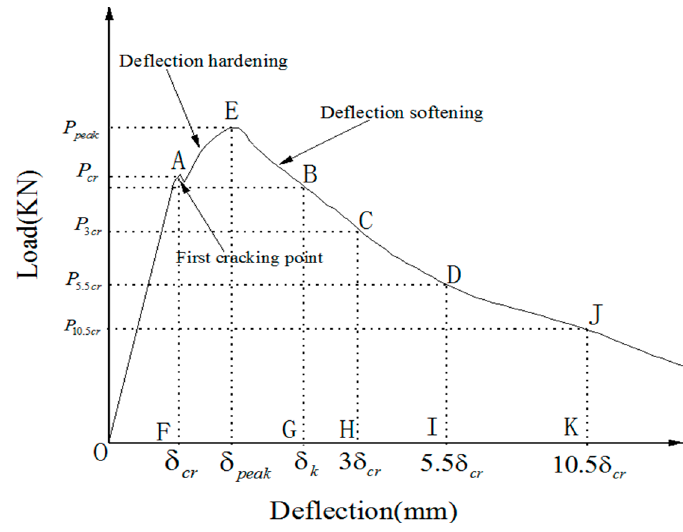
Figure 5. Typical load–deflection curve of FRC